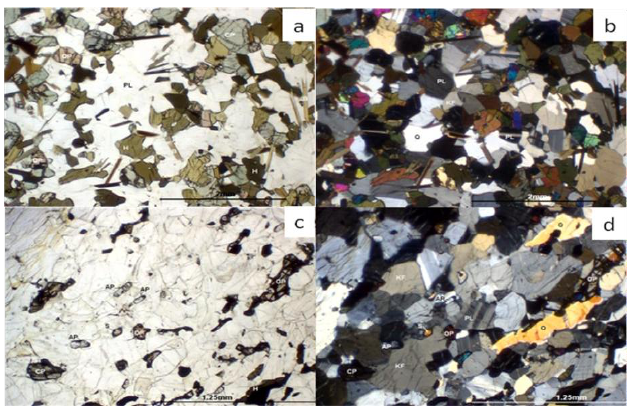
Figure 2: Photo micrographs showing major and accessory minerals in the charnockitic gneiss country rock under plane polarized light (a,c ) and cross polarized light (b,d) . PL:plagioclase, KF: K-feldspar, H: hornblende, CP: Clinopyroxene (diopside),OP: orthopyroxene (hypersthene), B: biotite, Q: quartz, A:apatite, S: sphene.